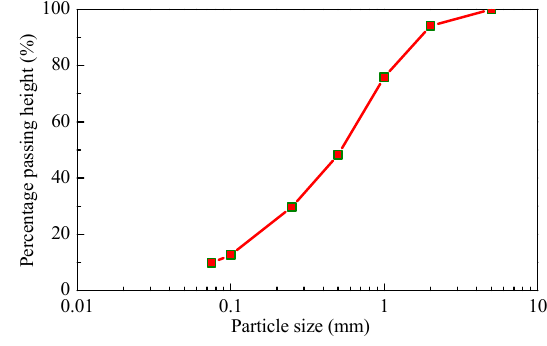
Figure 5. Soil grain size distribution.